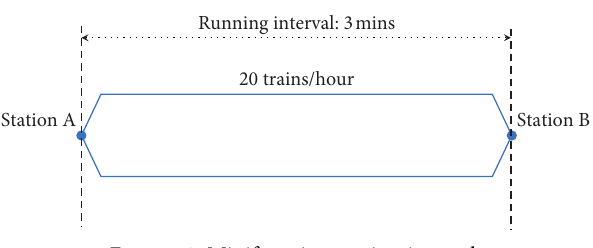
Figure 4: Minify train running